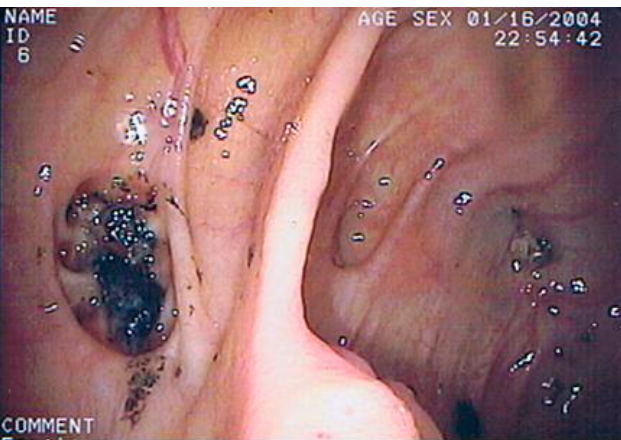
Figure 5. A 79-year-old man underwent colonoscopy due to massive rectal bleeding associated with severe anemia (hemoglobin 8.7 g/dL). The colonoscopy showed diverticulosis with signs of recent, but not current,